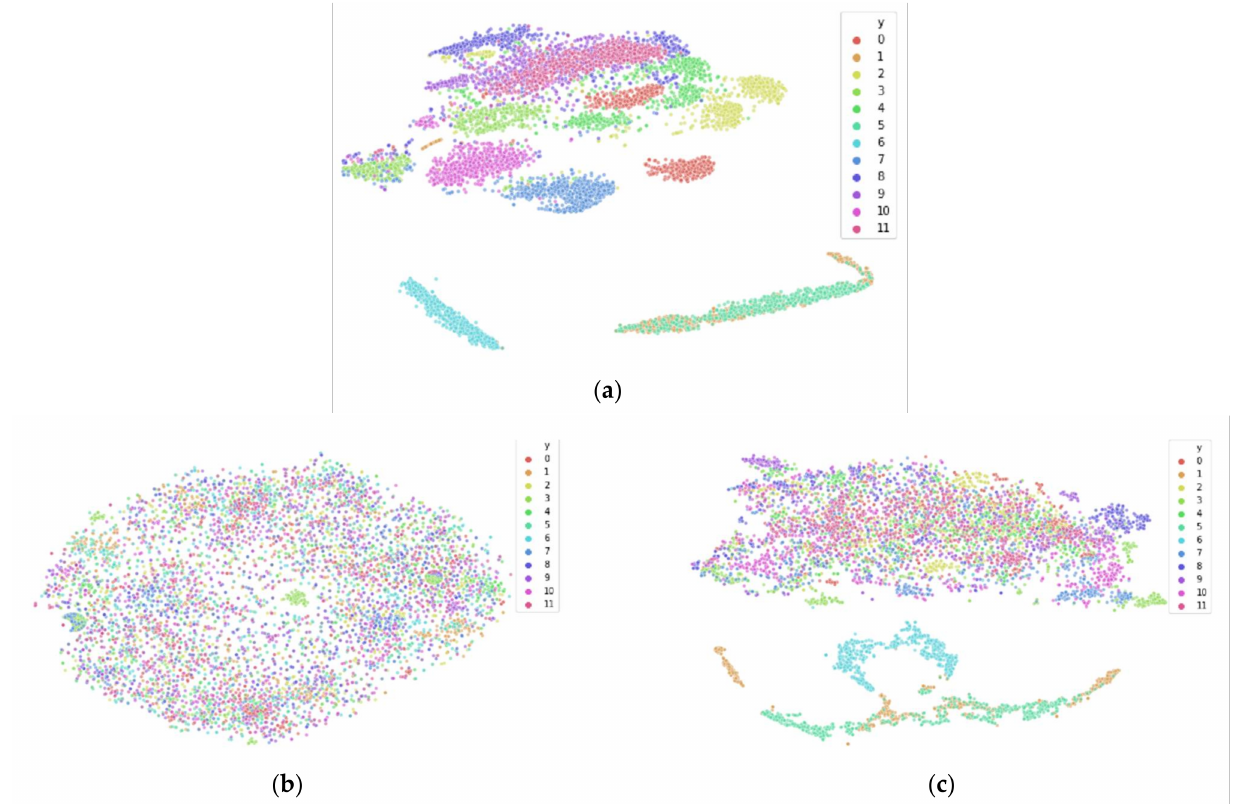
Figure 8. Results of visualizing the data using t-SNE for the spectral feature space before and after various data transforma- tions: ( a ) Before any transformations; ( b ) After applying shifted Heaviside transformation; ( c ) After applying shift to median transformation. Colors correspond to different participants, with the same color applied to the same participant in each figure. The dimensions of t-SNE are arbitrary distances that represent that closer neighboring points in low-dimensional space are likely to be neighbors in high-dimensional